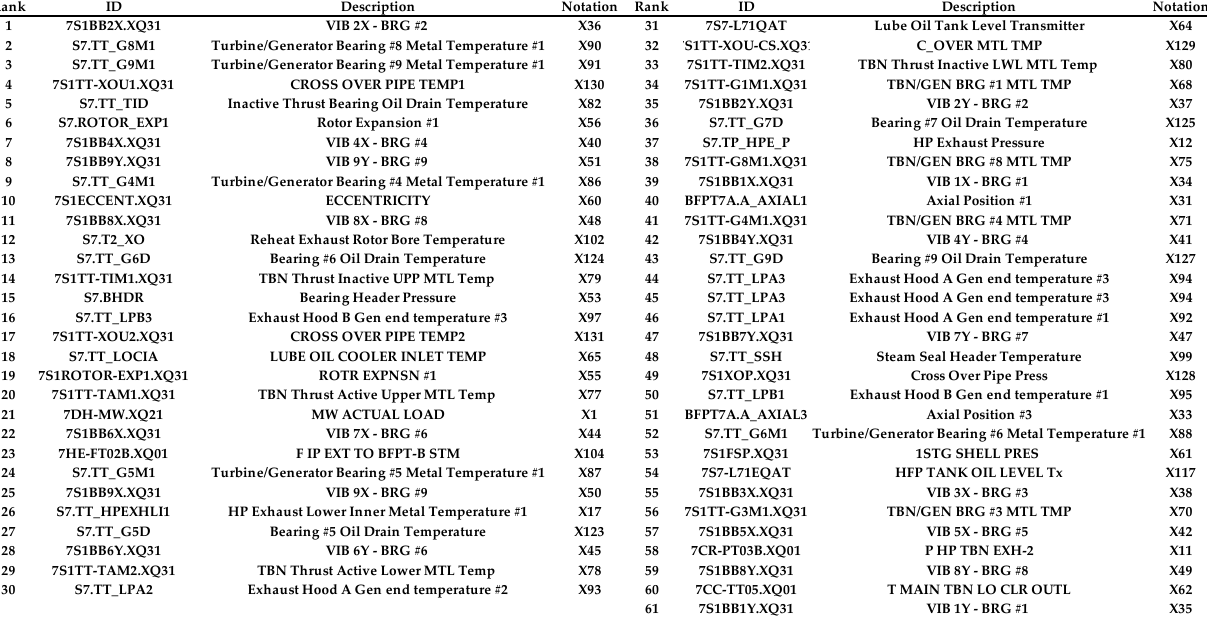
Figure 18. List of optimal sensors selected by mRMR algorithm.